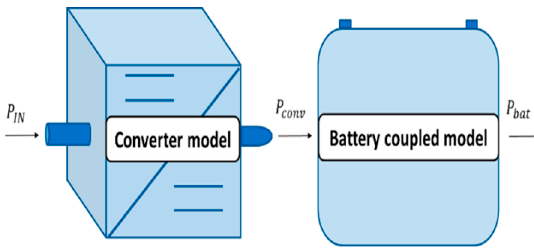
Figure 5. Converter and battery coupled model.